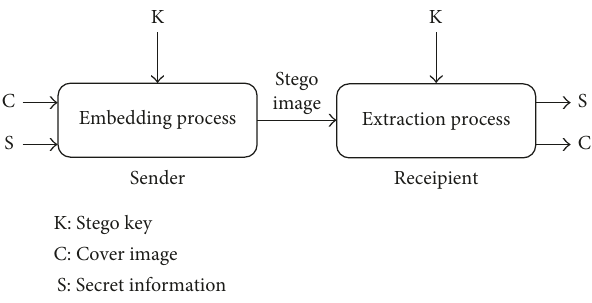
Figure 1: Basic schematic of the steganography